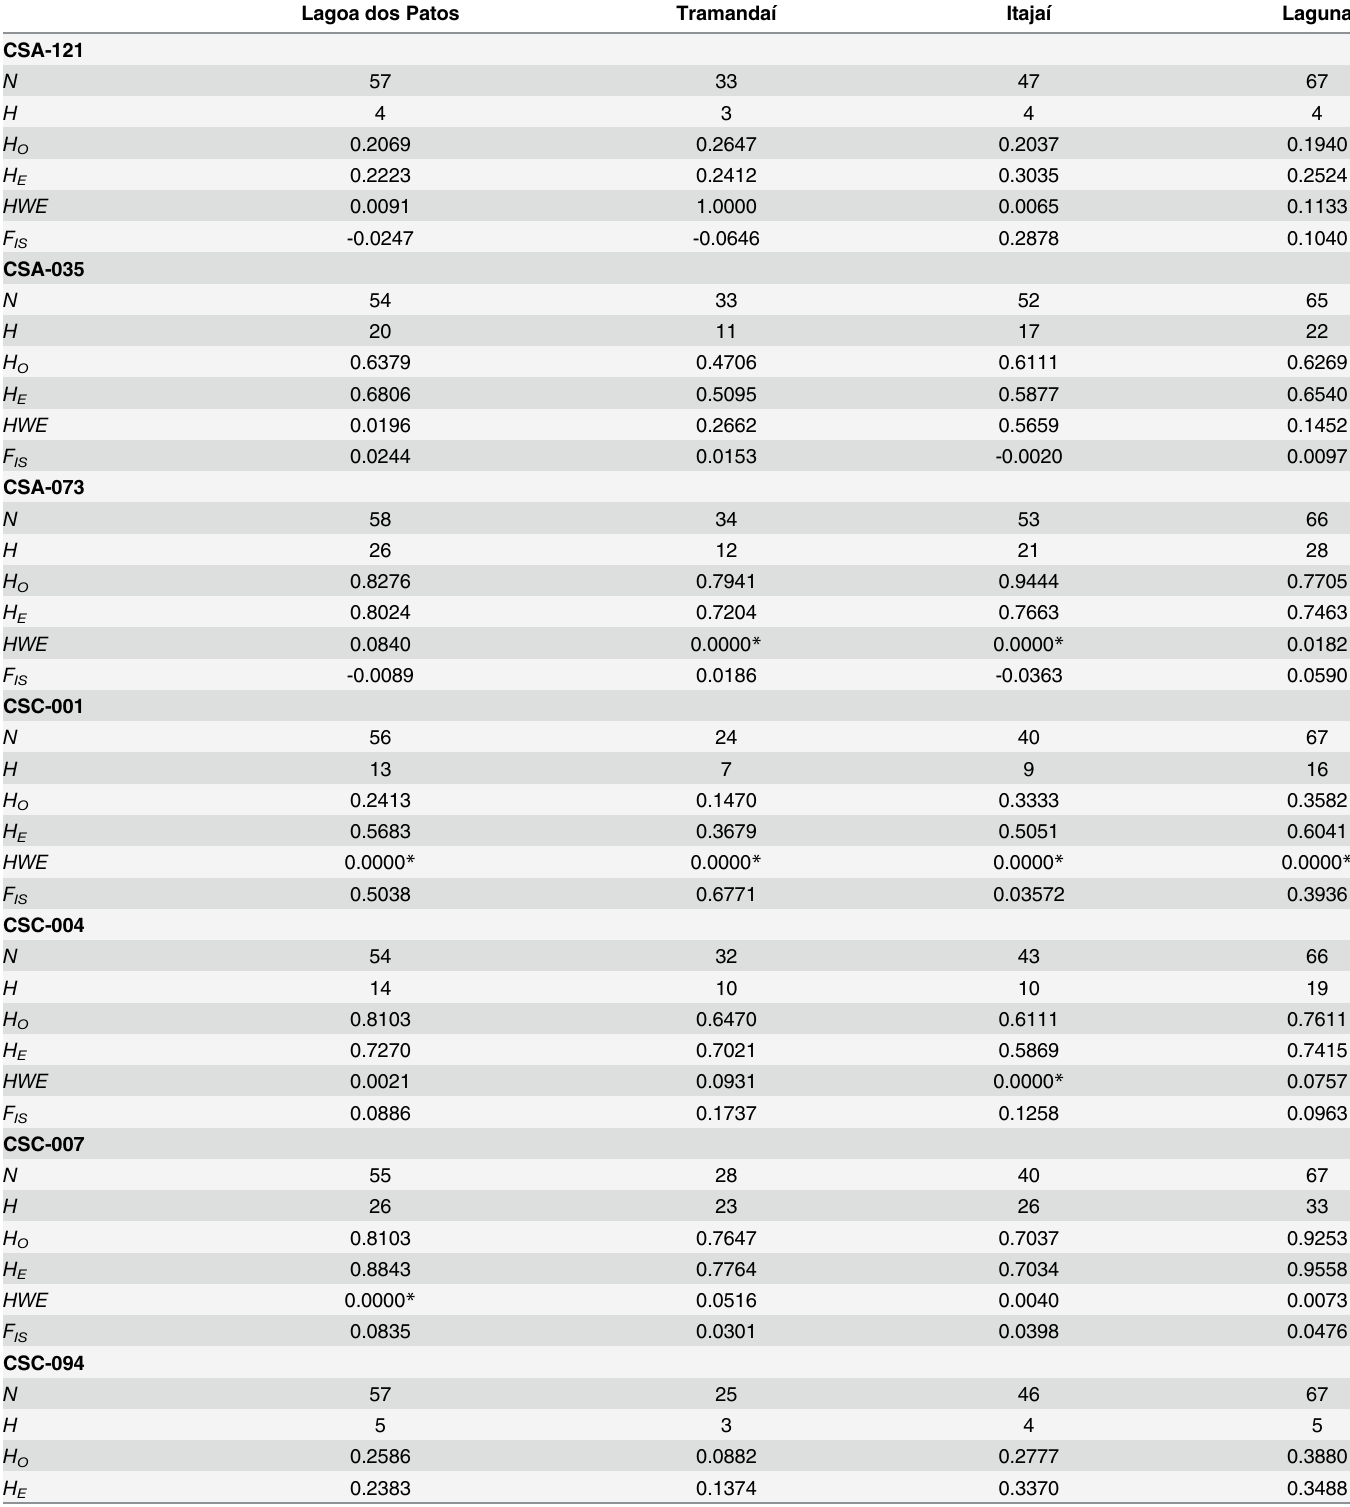
Table 4. Genetic diversity of seven nuclear loci of blue crabs populations sampled at the Western South